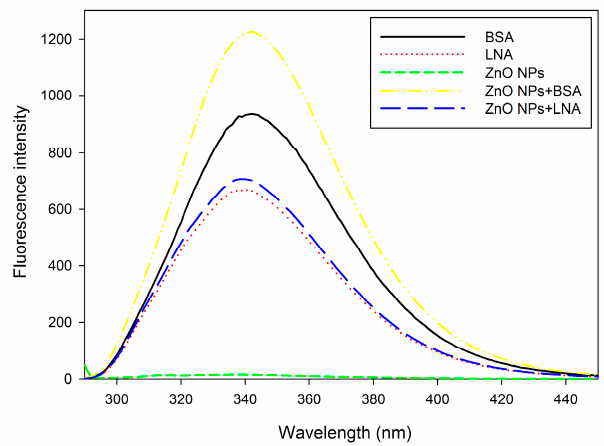
Figure 4. The fluorescence spectra ( λ = 280 nm) of bovine serum albumin (BSA), α -linolenic acid (LNA; complexed to BSA; referred as LNA) and ZnO NPs (code: XFI06) suspended in distilled and deionized water (DDW), 0.5% BSA, or 200 µM LNA.